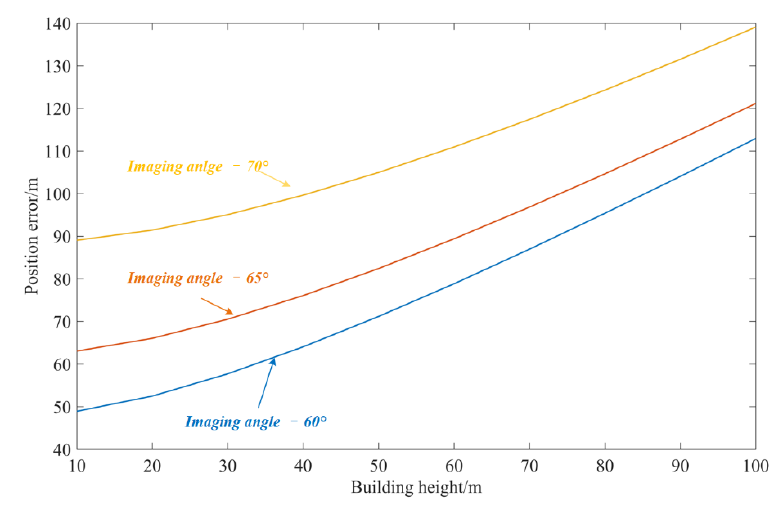
Figure 15. Schematic diagram of positioning error with building height.